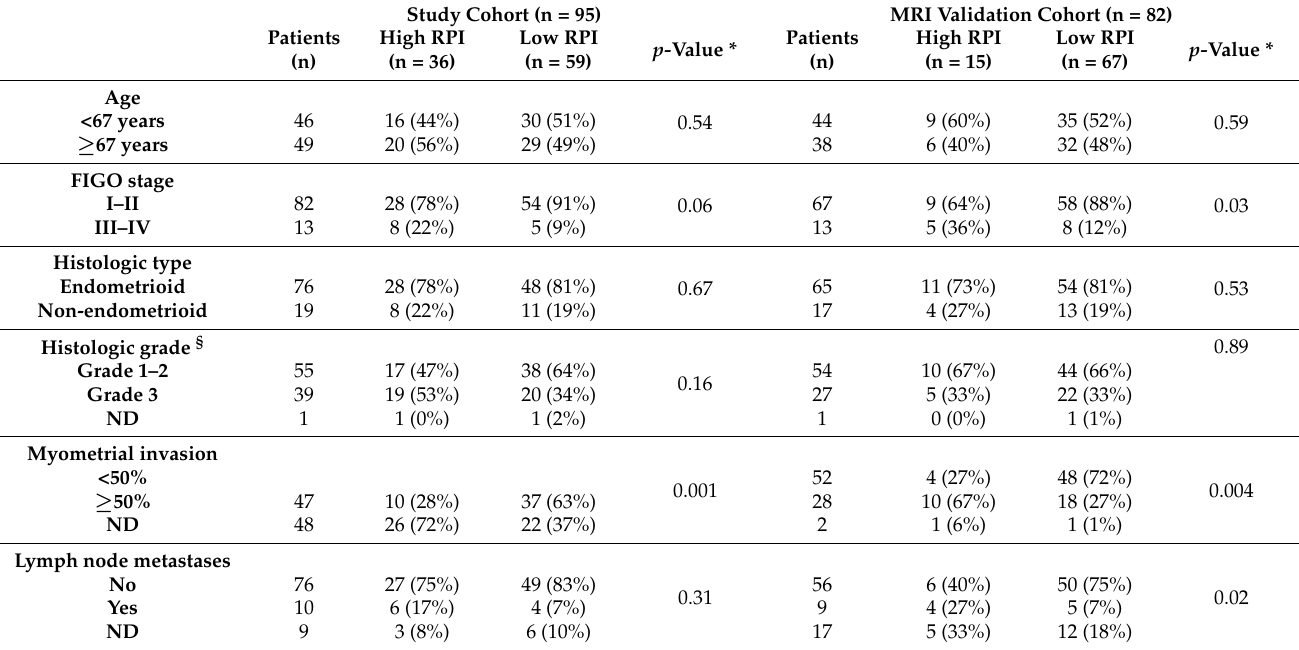
Table 2. Radiomic prognostic index (RPI) in relation to clinicopathological patient characteristics in the study cohort (n = 95) and the MRI validation cohort (n =